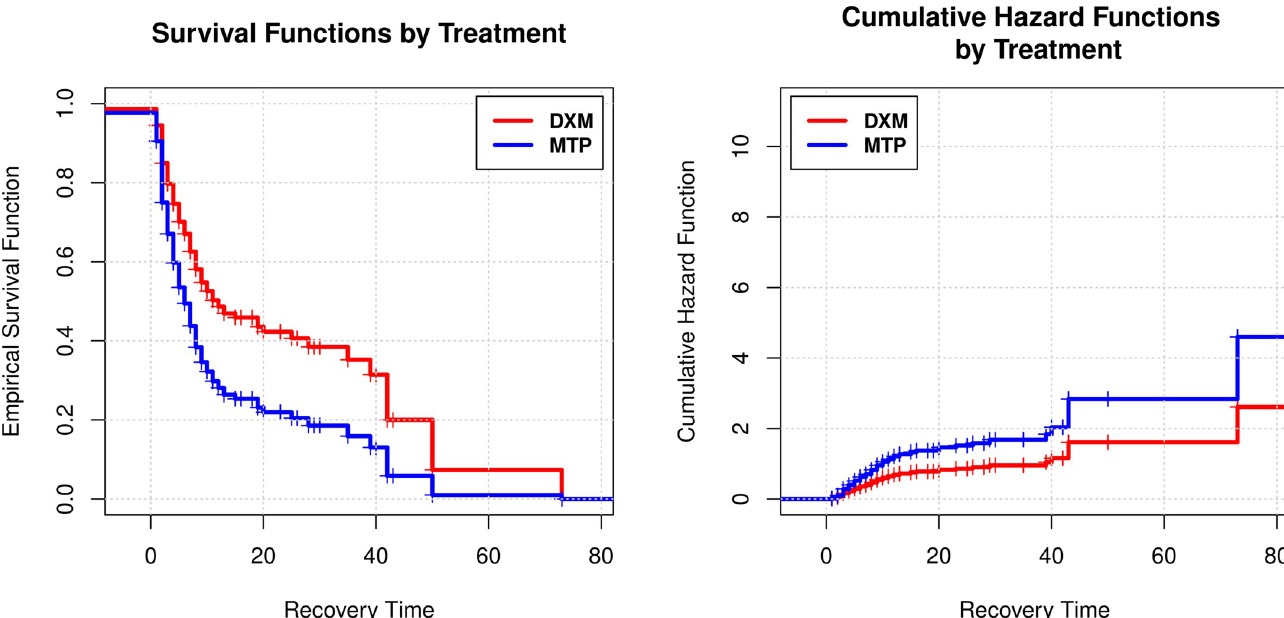
Fig 3. A. Survival function estimated by Cox model, according to treatment received: MTP vs DXM. B. Cumulative Hazard function estimated by Cox model, according to the MTP vs DXM treatment. https://doi.org/10.1371/journal.pone.0252057.g003 Yang et al. [25], evaluated 175 patients with severe Covid-19, documenting in the multivari- ate analysis as a protective factor against progression to critical disease the administration of methylprednisolone (p-value < 0 .001; OR: 0.054 95% CI: 0.017–0.173).